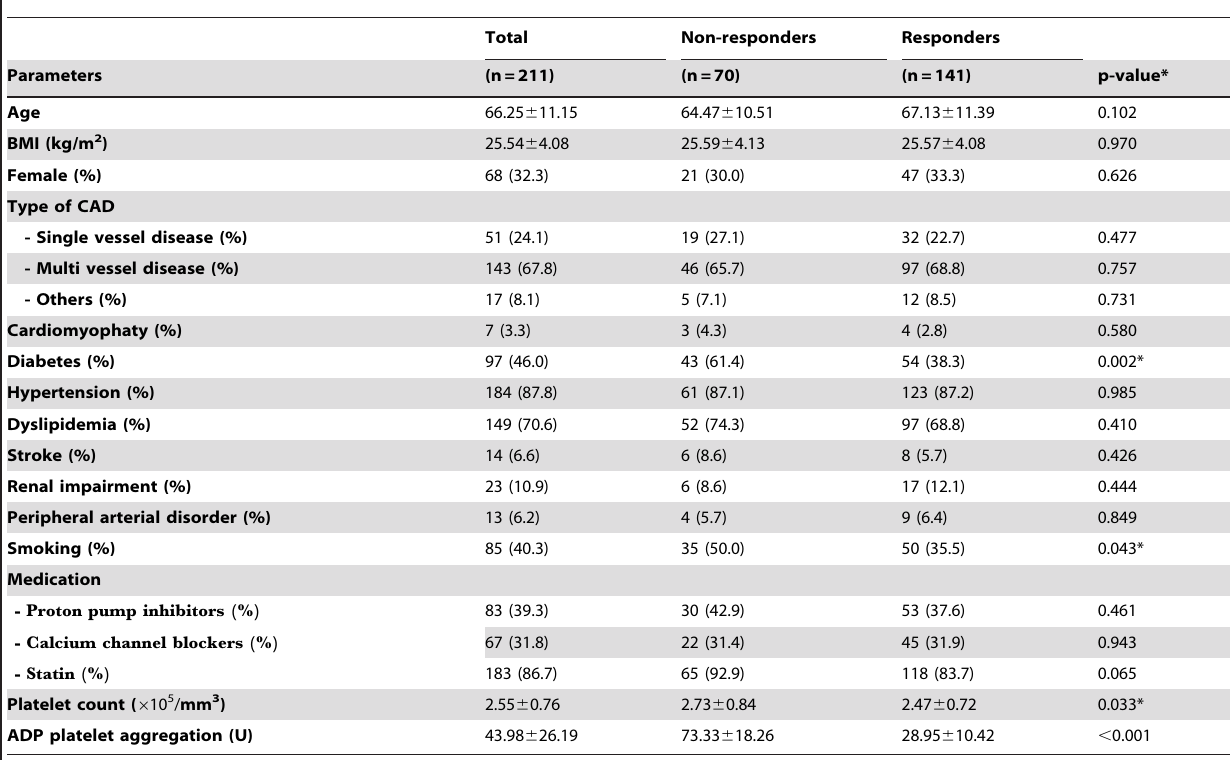
Table 1. Baseline characteristics of study